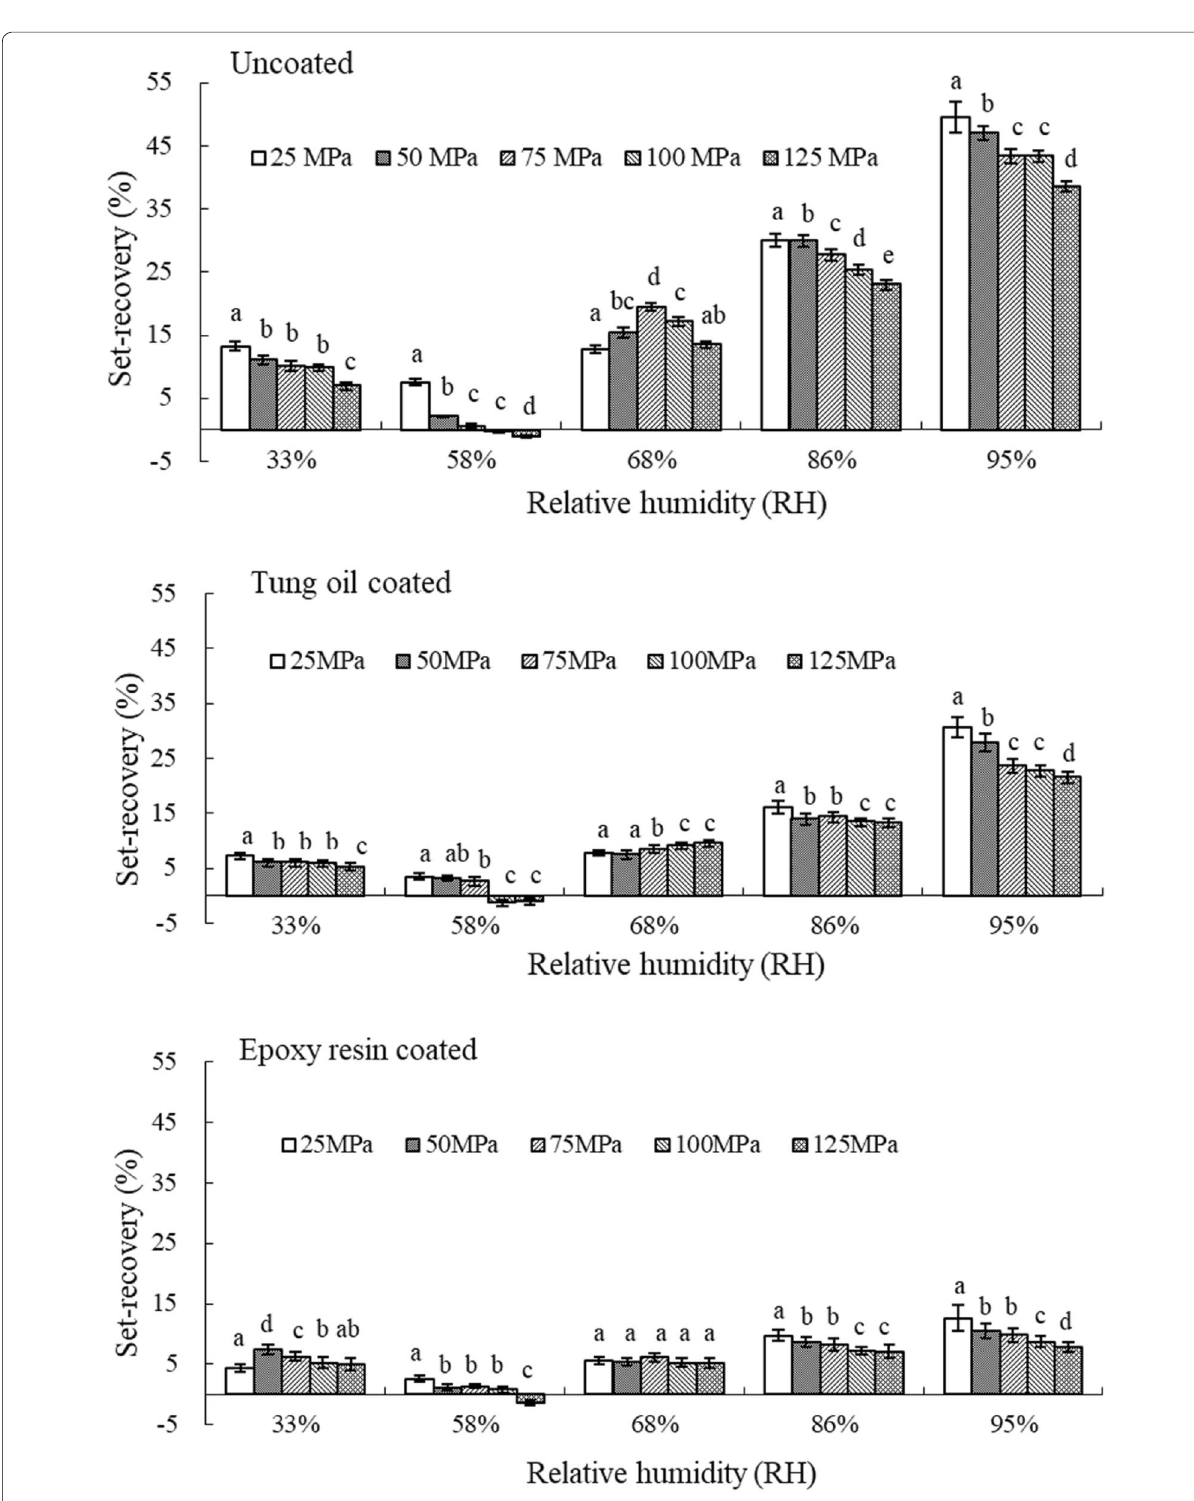
Fig. 7 Average set-recovery (%) of uncoated treated, TO-coated treated and ER-coated treated wood samples under different RH environments at 25 °C (error bars present standard deviations, and letters mean significantly different levels at p